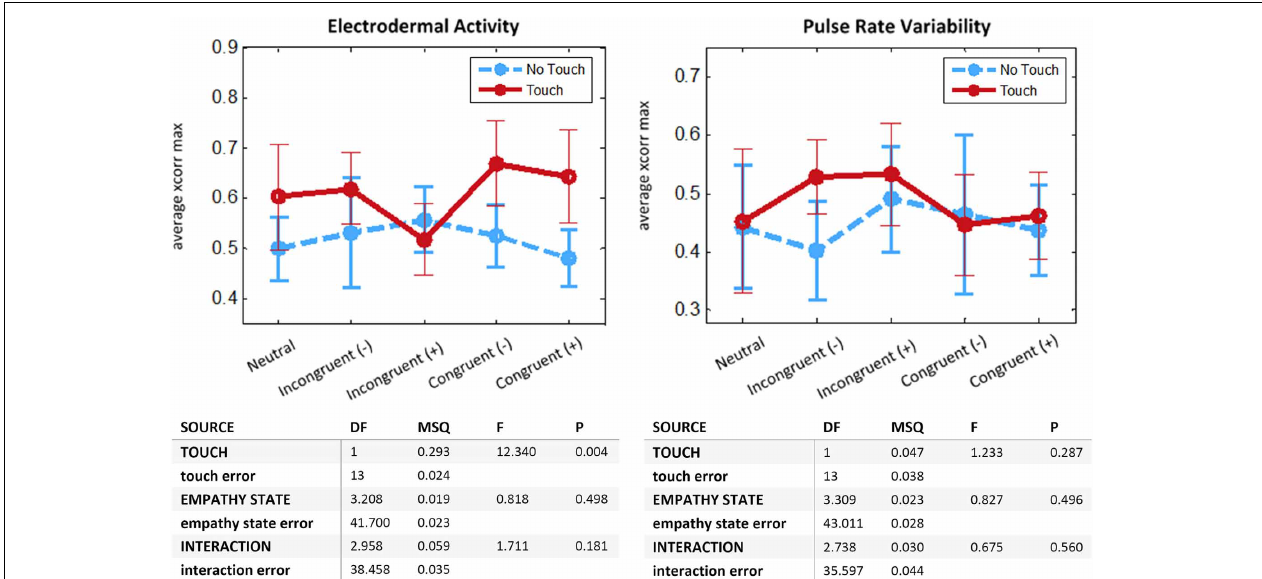
FIGURE 5 | Physiological coupling between romantic partners. N = 14 couples. For each run we compute the average cross-correlation after Fisher z-transform for interval ( − 1, 1s) around maximum value. Top: Means with